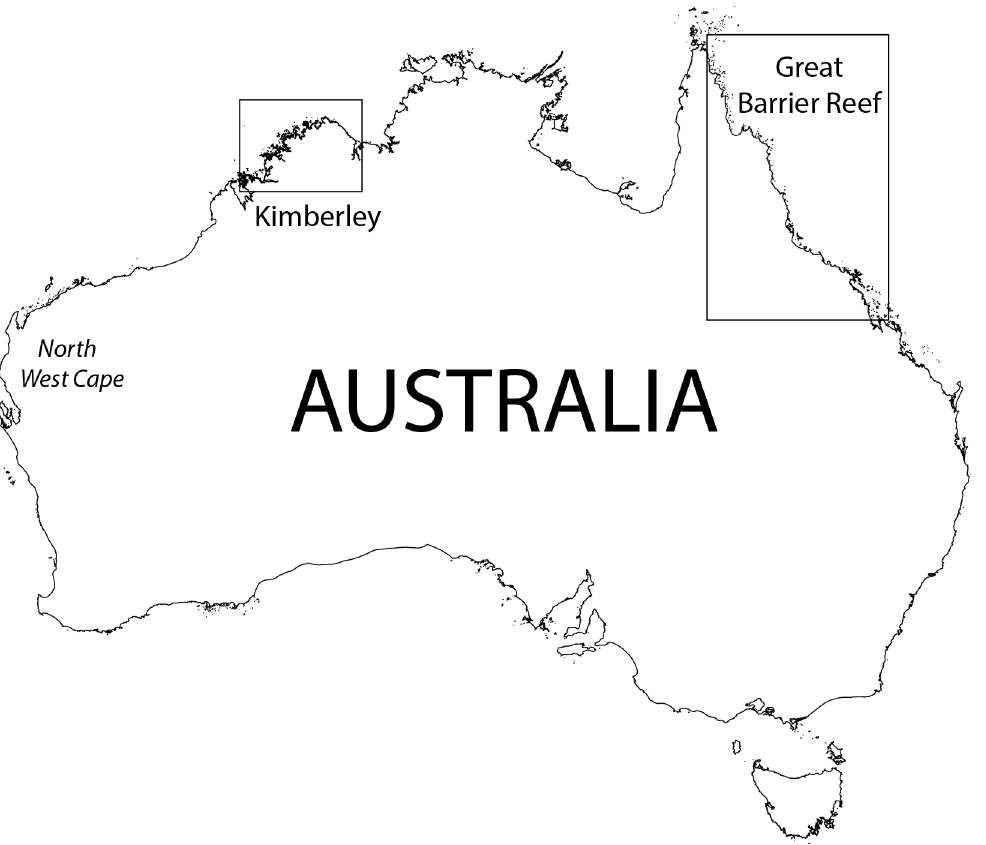
Fig 1. Map of Australia, showing the two different regions in this study – the Great Barrier Reef on the North East coast, and the Kimberley region on the North West coast.